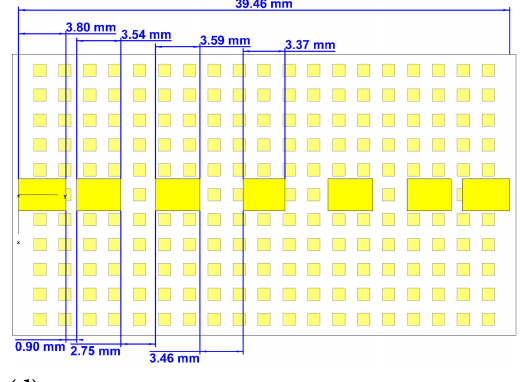
Figure 3. Filter comparison with PMC vs lossless PINS and vs lossy